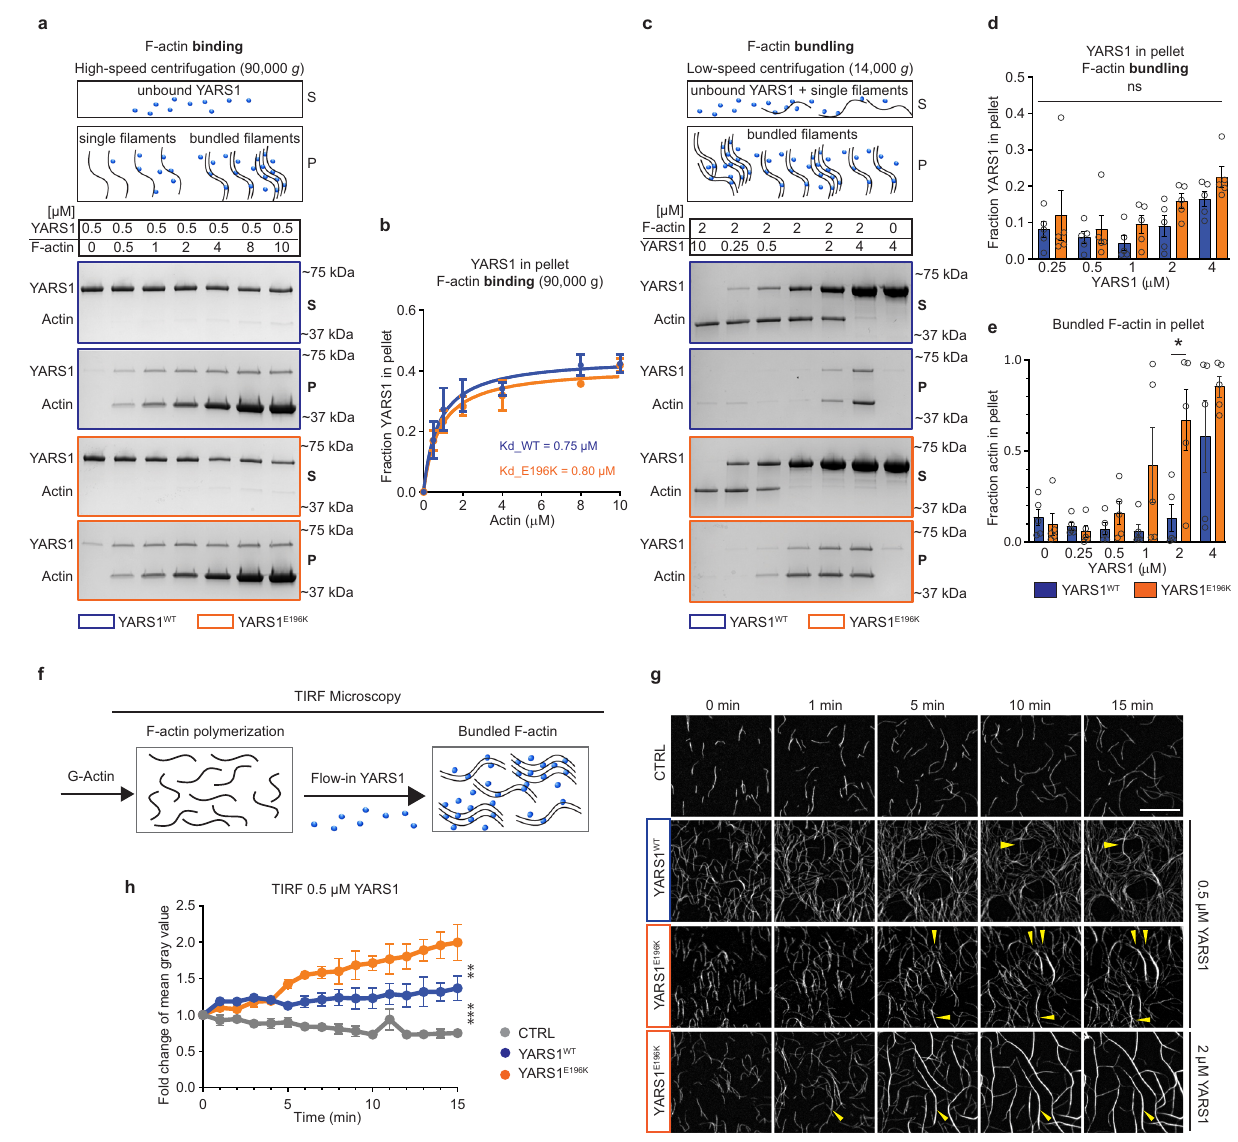
Fig. 2 | YARS1 binds to F-actin and organizes actin fi laments in vitro. a Coomassie-stained gels of supernatant (S) and pellet (P) fractions from high- speed pelleting (see schematic) of 0.5 µ M YARS1 WT or YARS1 E196K upon increasing F-actin concentrations. b Graphical representation of the YARS1 fraction in the pellet obtained in three independent experiments, fi tted into Michaelis-Menten nonlinear curve. c F-actin bundling capacity of YARS1 proteins tested upon low- speed pelleting (see schematic) of increasing concentrations of YARS1 and pre- assembled2 µ MF-actin.Graphsin d and e showthefractionofbundledF-actinand YARS1 in the pellets from fi ve independent experiments; error bars in b , d , and e — SEM; * p =0.0187, two-sided unpaired t test. Supernatant and pellet samples